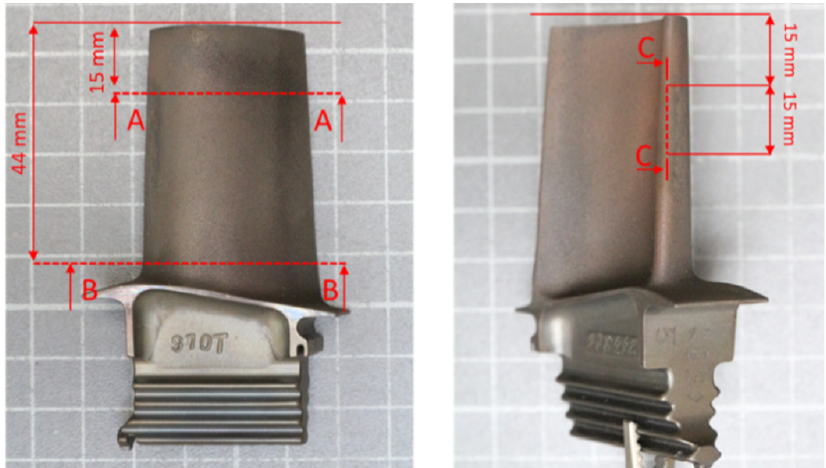
Figure 2. Scheme of cutting out fragments of the blade with a prototype protective coating for the execution of metallographic specimens of the blade material.